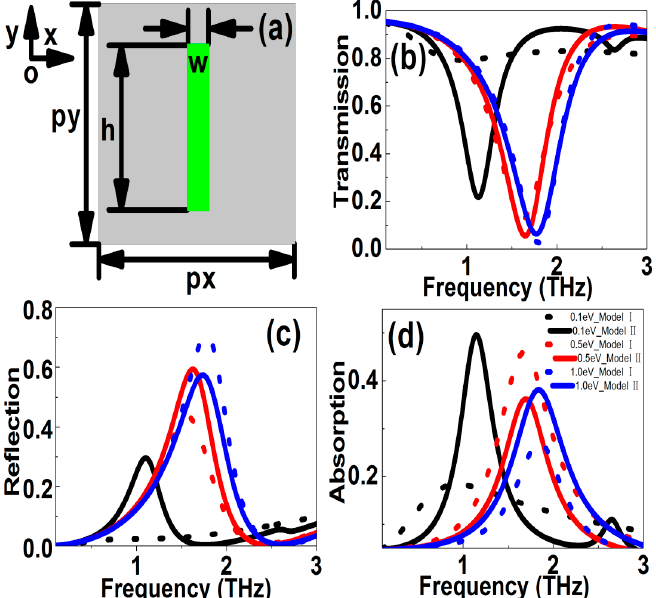
Figure 4. ( a ) Sketch of graphene cut wire patterns. ( b–d ) The transmission, reflection, absorption resonant curves versus frequency at different models. The Fermi levels were 0.1, 0.2, 0.3, 0.4, 0.5, 0.6, 0.8, and 1.0 eV, respectively. The stripe length and width were 48 μ m and 8 μ m, respectively. The periodic lengths along x and y directions were both 72 μ m.